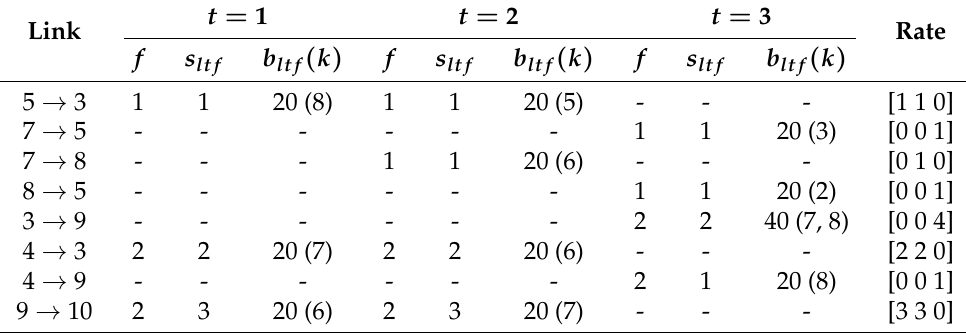
Table 5. Resource Allocation Result for Case